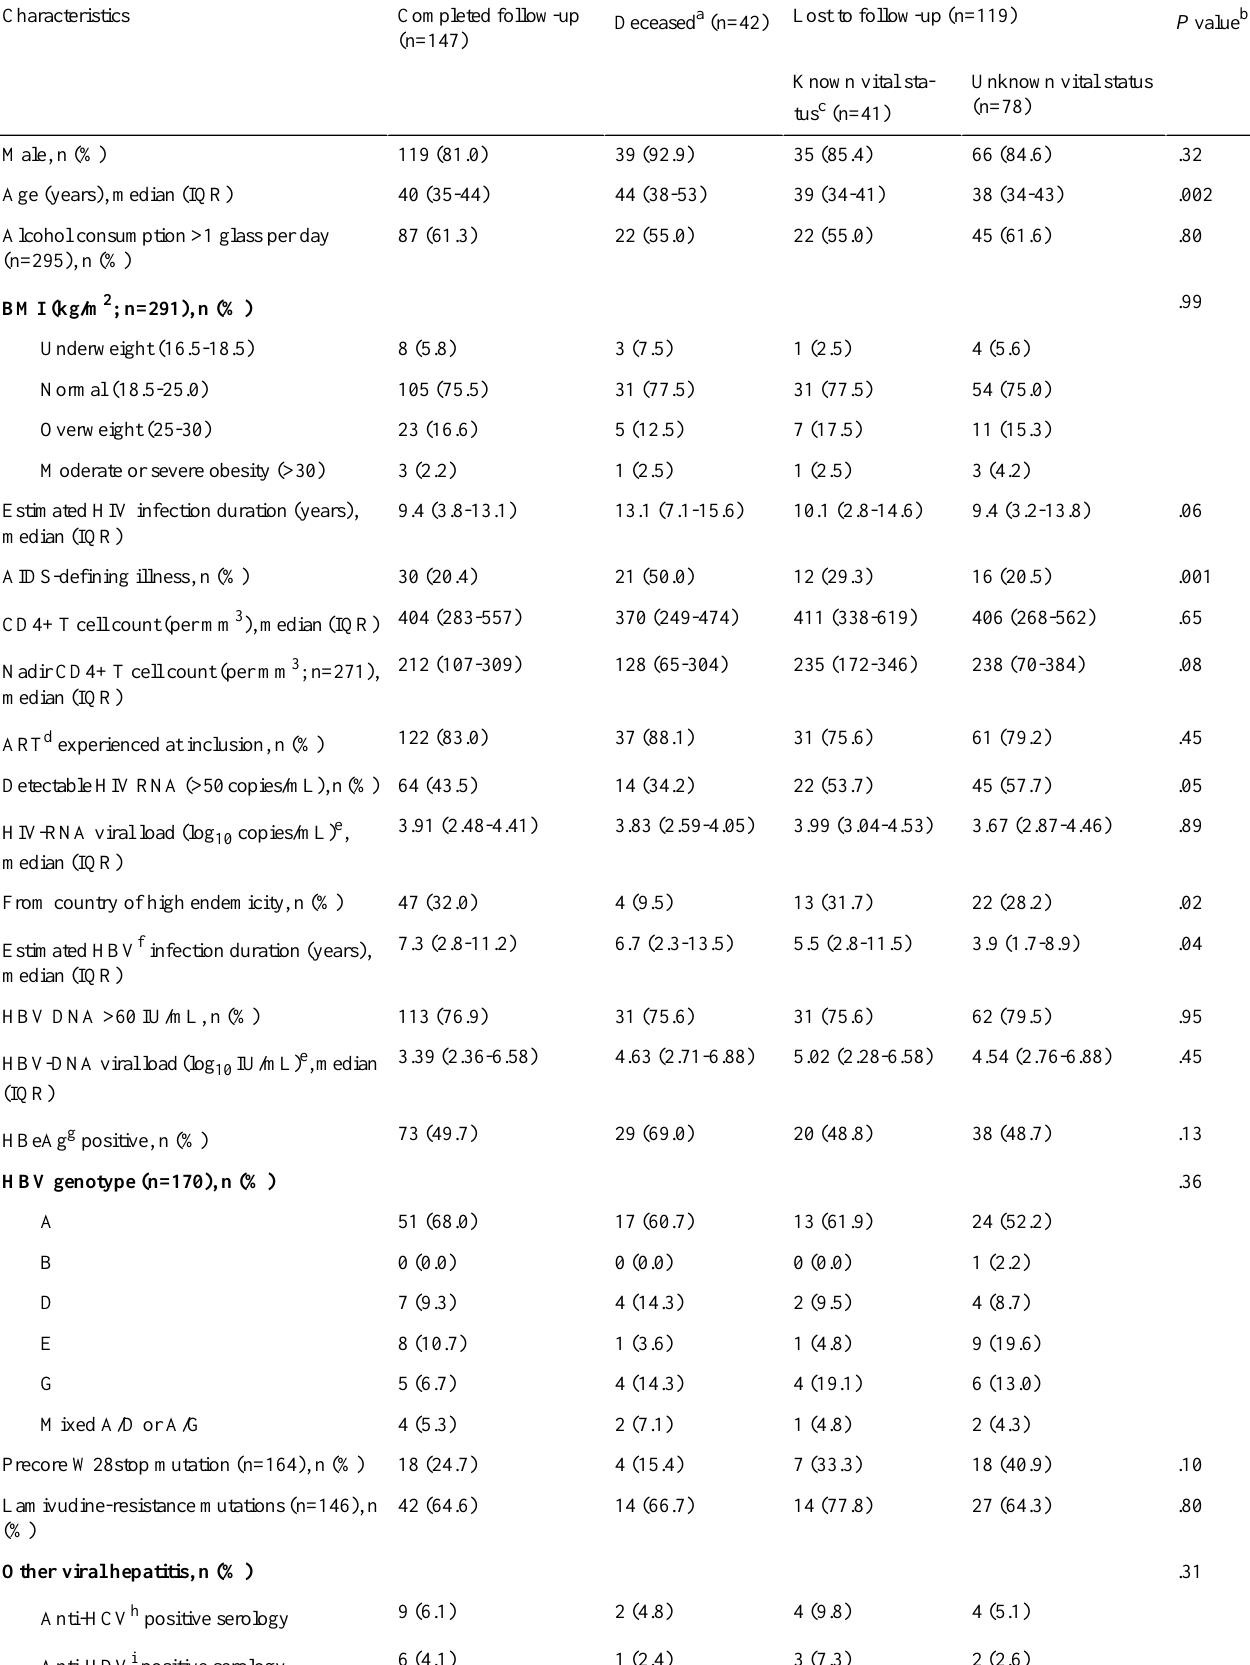
Table 3. Characteristics of the study population at cohort inclusion, stratified by those completing the third phase cross-sectional visit, deceased, and lost to follow-up with known or unknown vital